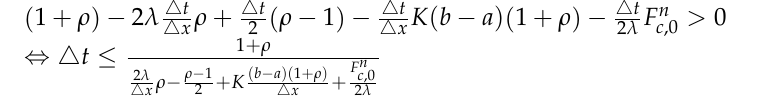
t for the hyperbolic transmission condition with (cid:52) a ) for the transmission between the two-dimensional parabolic Equation (57) with the −